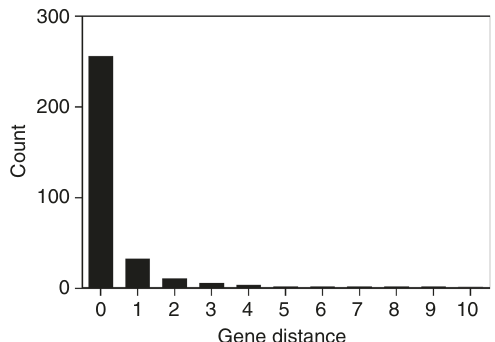
Fig. 4 A majority of E. coli essential genes are adjacent to a non-essential gene that is part of the Keio knockout collection. Gene distance is a count of the minimum number of genes that separate an essential gene from a